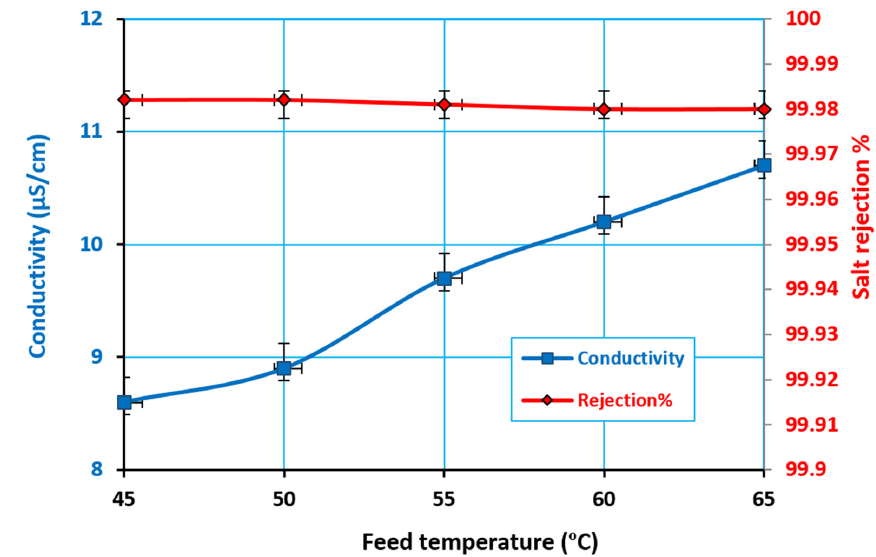
Figure 4. Influence of the hot feed temperature on the permeate flux at various concentrations and a feed flow rate of 1.07 L/min.